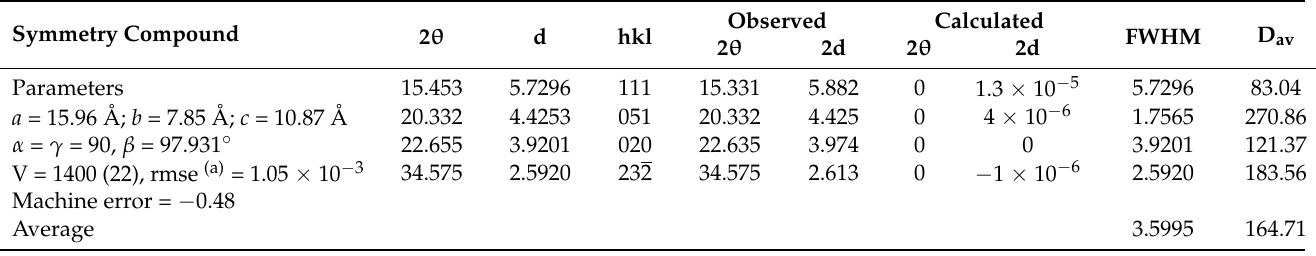
Figure 5. XRD pattern of cellulose sample. Table 1. The computation data resulted from the application Refine Version 3.0 Software Program (Kurt Barthelme’s and Bob Downs) for [Indol-4Ap] TF .